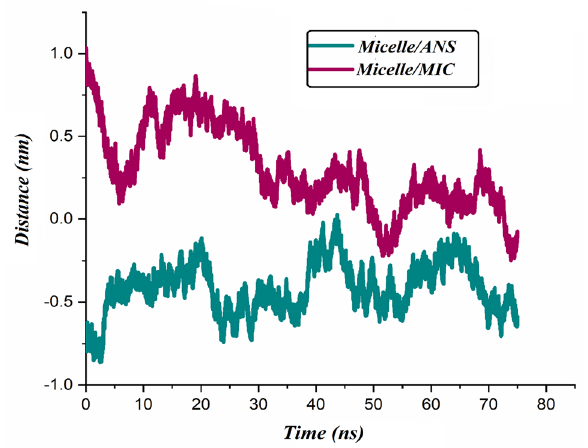
Figure 12. The average COM distance between micelle and drug molecules during of